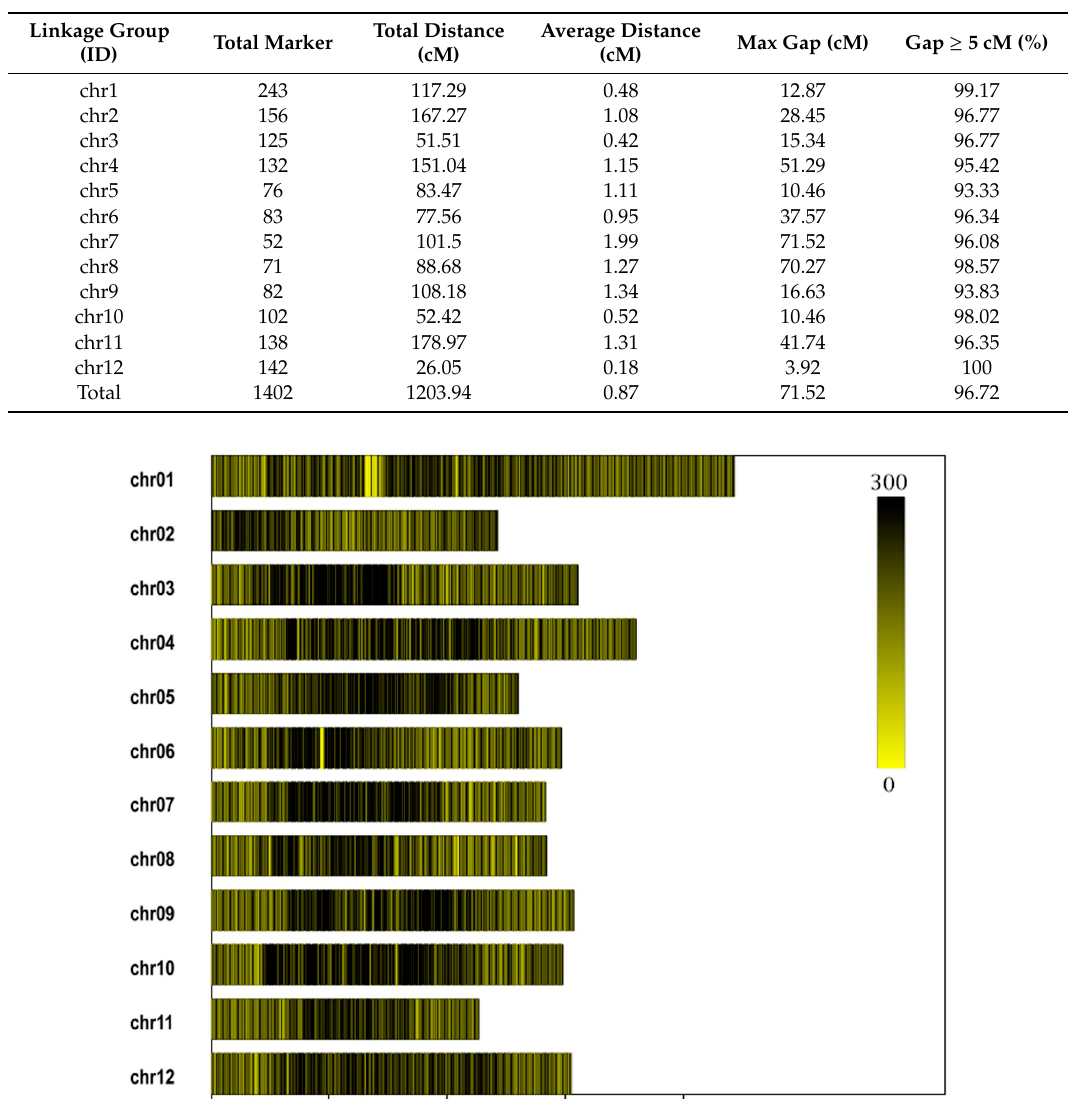
Figure A2. Haplotype maps for 12 linkage groups of the integrated genetic map for tetraploid potato. The haplotype maps consist of 12 maps from LG chr 1 to LG chr 12. Each two columns represent the genotype of an individual. Blank columns are used between two individuals. The first and second columns represent the paternal and maternal chromosome, respectively. Rows correspond to genetic markers. Green and blue boxes indicate one chromatid from parents, and gray boxes indicate missing data.